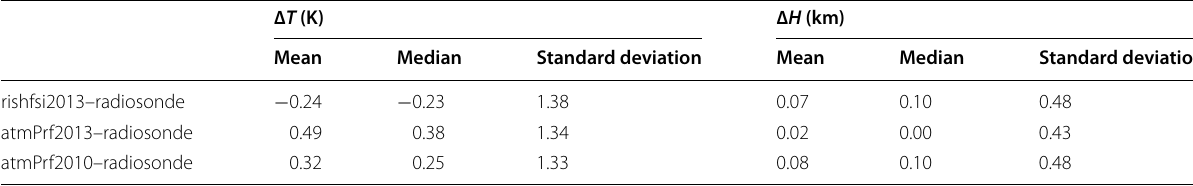
Table 4 Statistical differences of CPT between GPS-RO and a radiosonde ∆ T